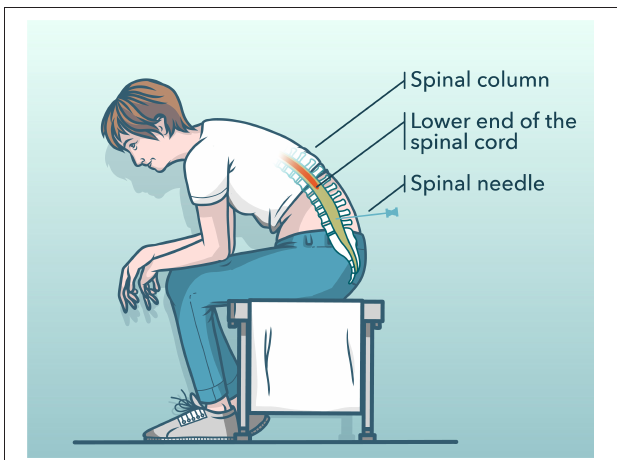
FIGURE 1 | Illustrating pictogram of the diagnostic procedure used for the enhanced consent